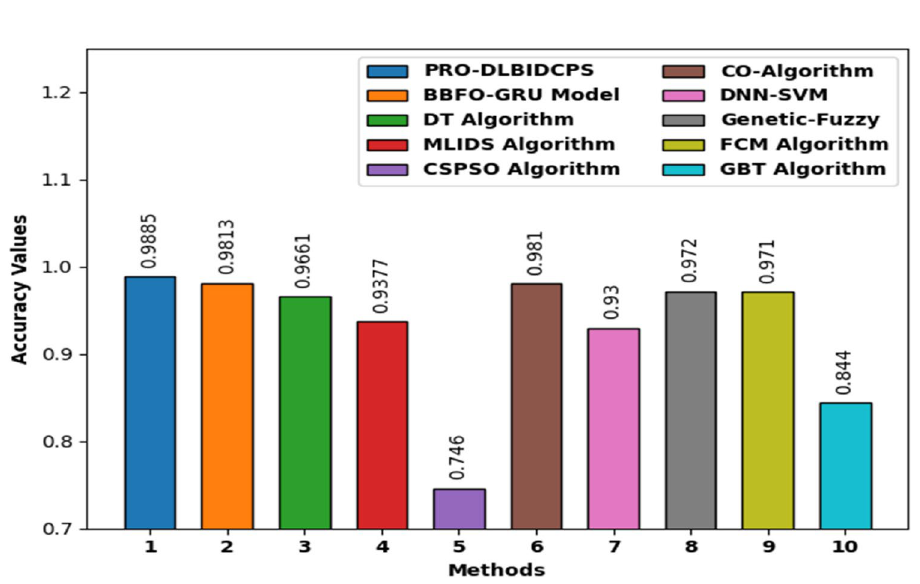
Figure 12. Comparative accuracy analysis of the PRO-DLBIDCPS